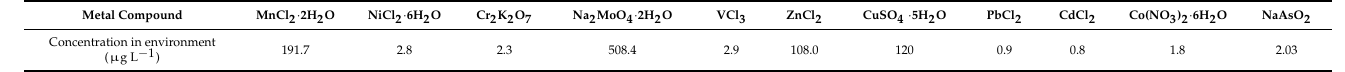
Table 3. Heavy metal (HM) compounds and their experimental